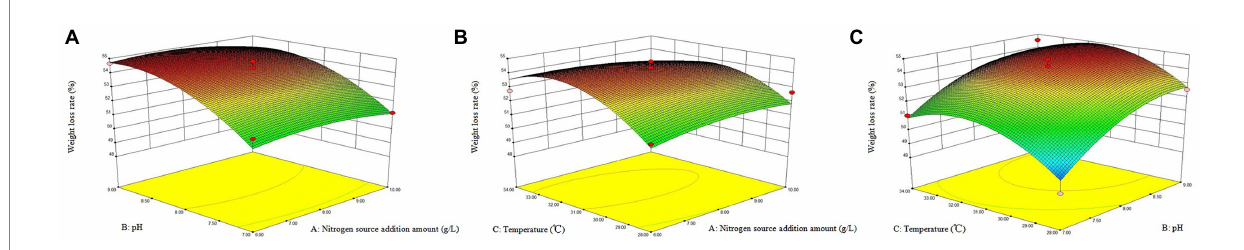
FIGURE 7 Cellulase activity of ZJW-6 under aerobic and anaerobic conditions. EC, extracellular enzymes; IC, intracellular enzymes. (A) Exoglucanase; (B) Endoglucanase; (C) β -glucosidase.